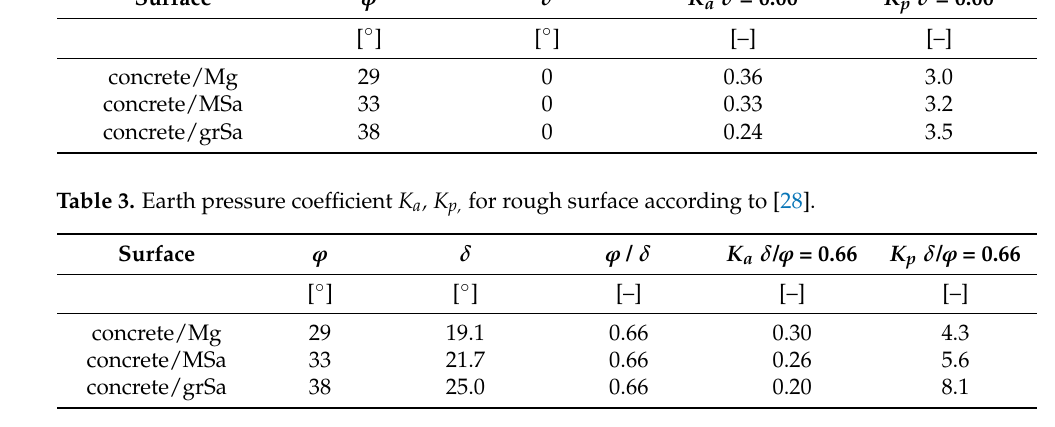
Table 2. Earth pressure coefficient K a , K p, for smooth surface according to [28]. Surface